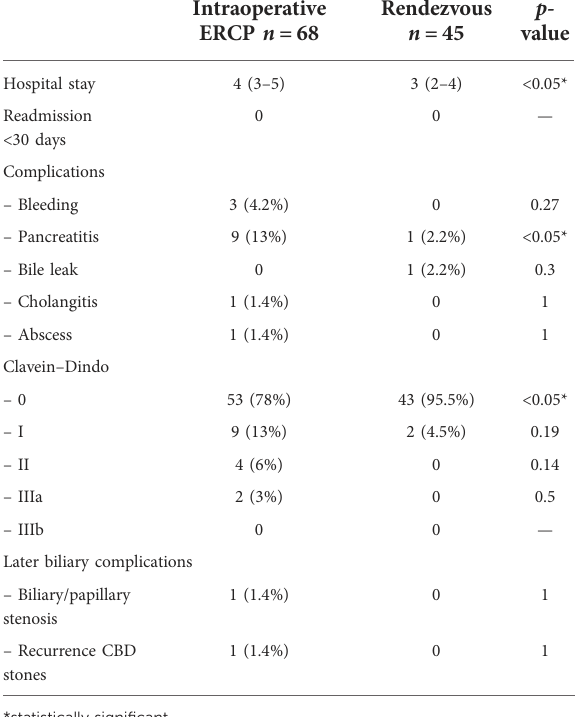
TABLE 3 Overall morbidity and speci fi c complications of intraoperative ERCP and rendezvous groups. Postoperative